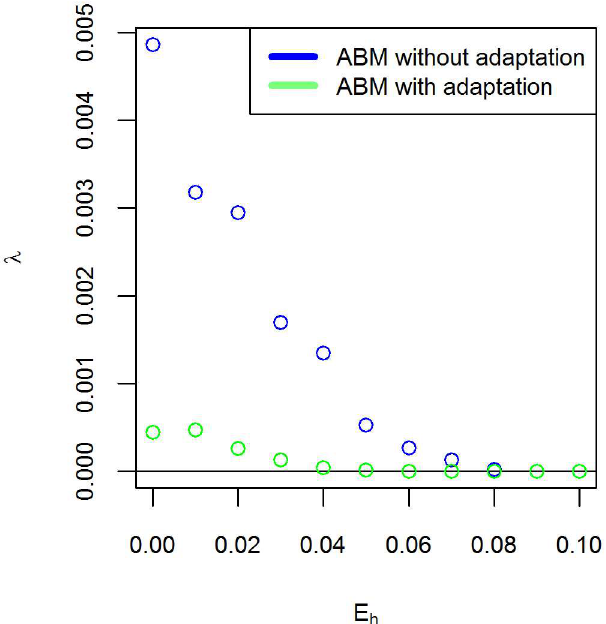
Fig 11. Extinction parameter λ as function of E h . The extinctionparameter λ (Eq 9) as function of the harvest cost E h . The values were estimated by fitting Eq 9 to the output of 100 replicateruns of the ABMs with adaptation and without adaptation.The value of E h where λ reaches zero correspondsto the tipping point where there is no extinctionon long